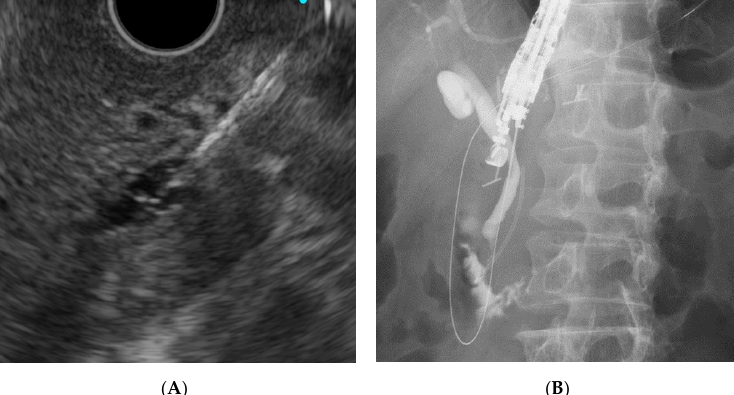
Figure 1. The distal extrahepatic bile duct/duodenal second part (DEHBD/D2) route. Endoscopic ultrasound image ( A ) showing needle puncture of the distal extrahepatic bile duct from the duodenal second part. Fluoroscopic image ( B ) showing that the guidewire passed through the papilla into the duodenum.